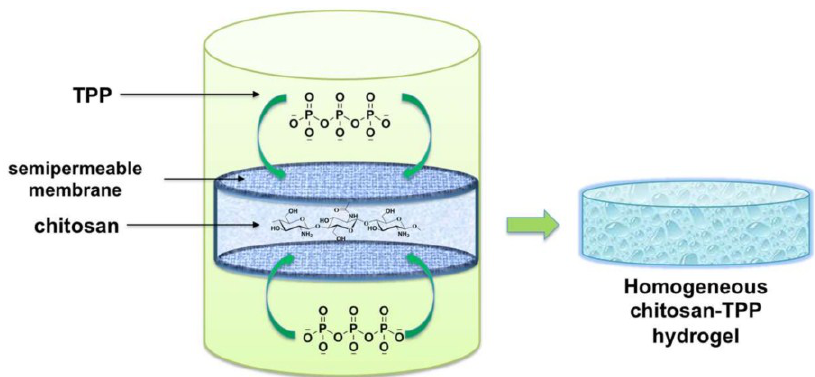
Figure 3. Experimental setup for developing chitosan-tripolyphosphate (TPP) macroscopic gels via external gelation. Adapted with permission from [42], Copyright 2014 American Chemical Society.